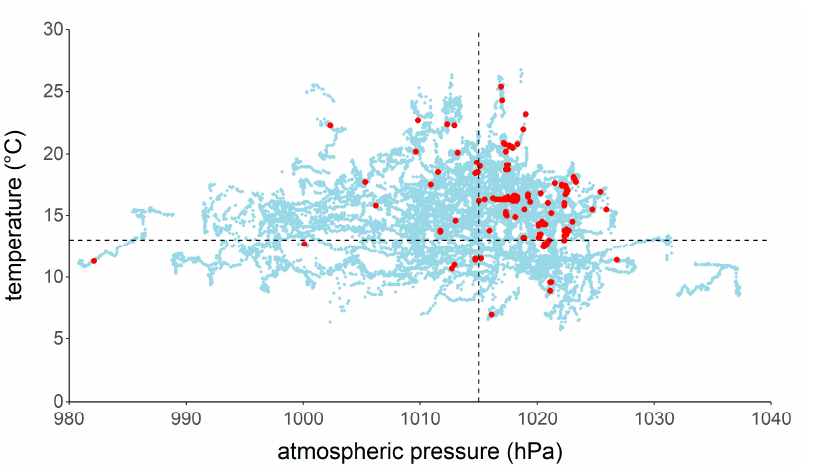
Figure 6. Temperature and atmospheric pressure measurements during the survey periods (light blue dots) and temperature and atmospheric pressure values when bats were recorded (red dots). Ninety percent of bat recordings were made when the temperature exceeded 13 °C (horizontal dashed line) and atmospheric pressure was higher than 1015 hPa (vertical dashed line).